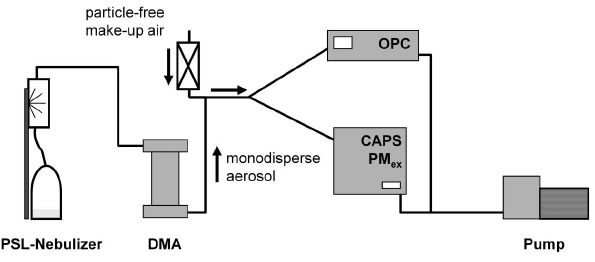
Figure 1. Experimental set-up for the pathlength adjustment of the CAPS PM ex with Fig. 1. Experimental set-up for the pathlength adjustment of the monodisperse PSL spheres. CAPS PM ex with monodisperse PSL